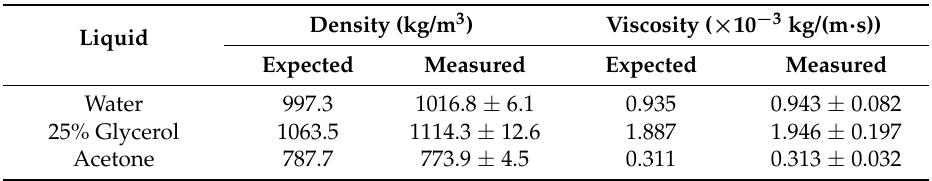
Figure 6. ( a ) Amplitude and phase of the transfer function for the microscale-thickness cantilevers under the fluid-structure interaction in air (760 mmHg), water, 25% ( v / v ) glycerol, and acetone, with their predicted values; ( b ) Measured density and viscosity of the liquids at different frequencies. Table 2. Mean values and standard deviations of the measured densities and viscosities of the liquids at 23 °C and their comparison to the expected values from the literature [19,20].